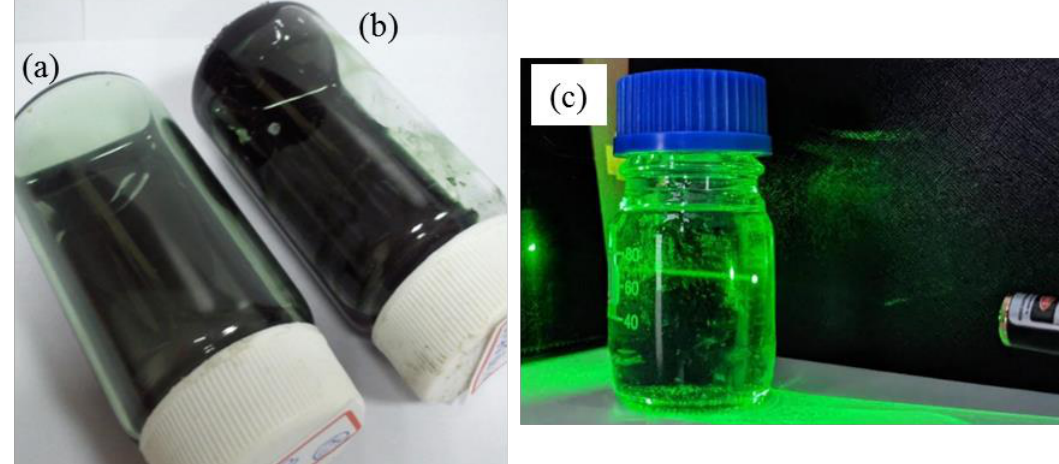
Figure 2. Photographs of PANDB dissolved in xylene: ( a ) PANDB synthesized in xylene; ( b ) PANDB synthesized in aqueous solution; and ( c ) PANDB synthesized in xylene showing the Tyndall effect.